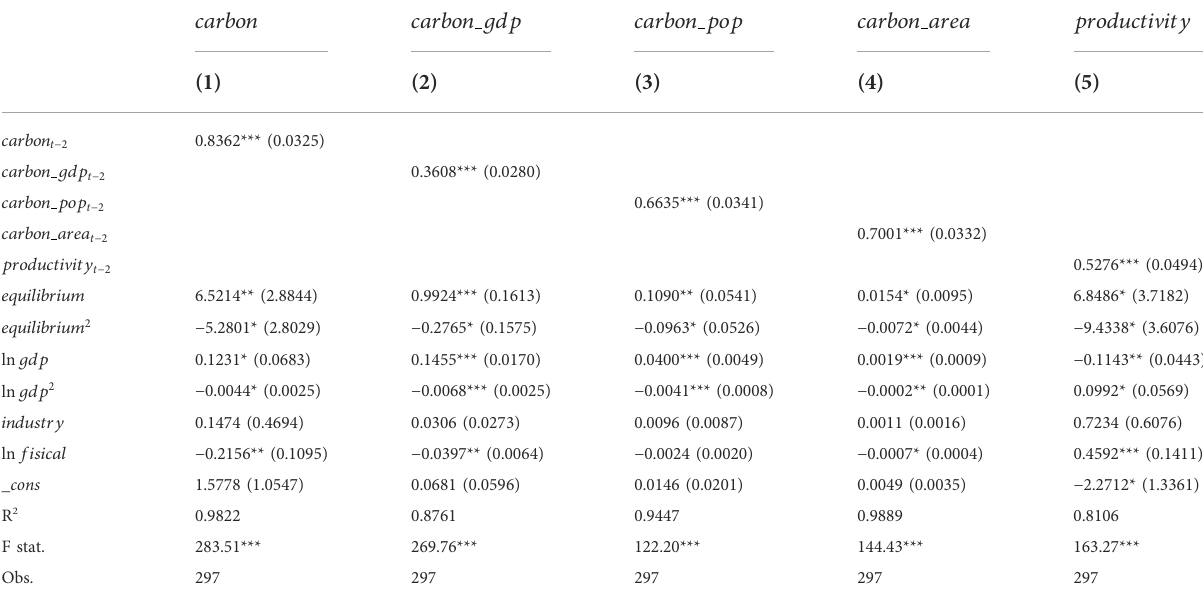
TABLE 2 Baseline regression estimation